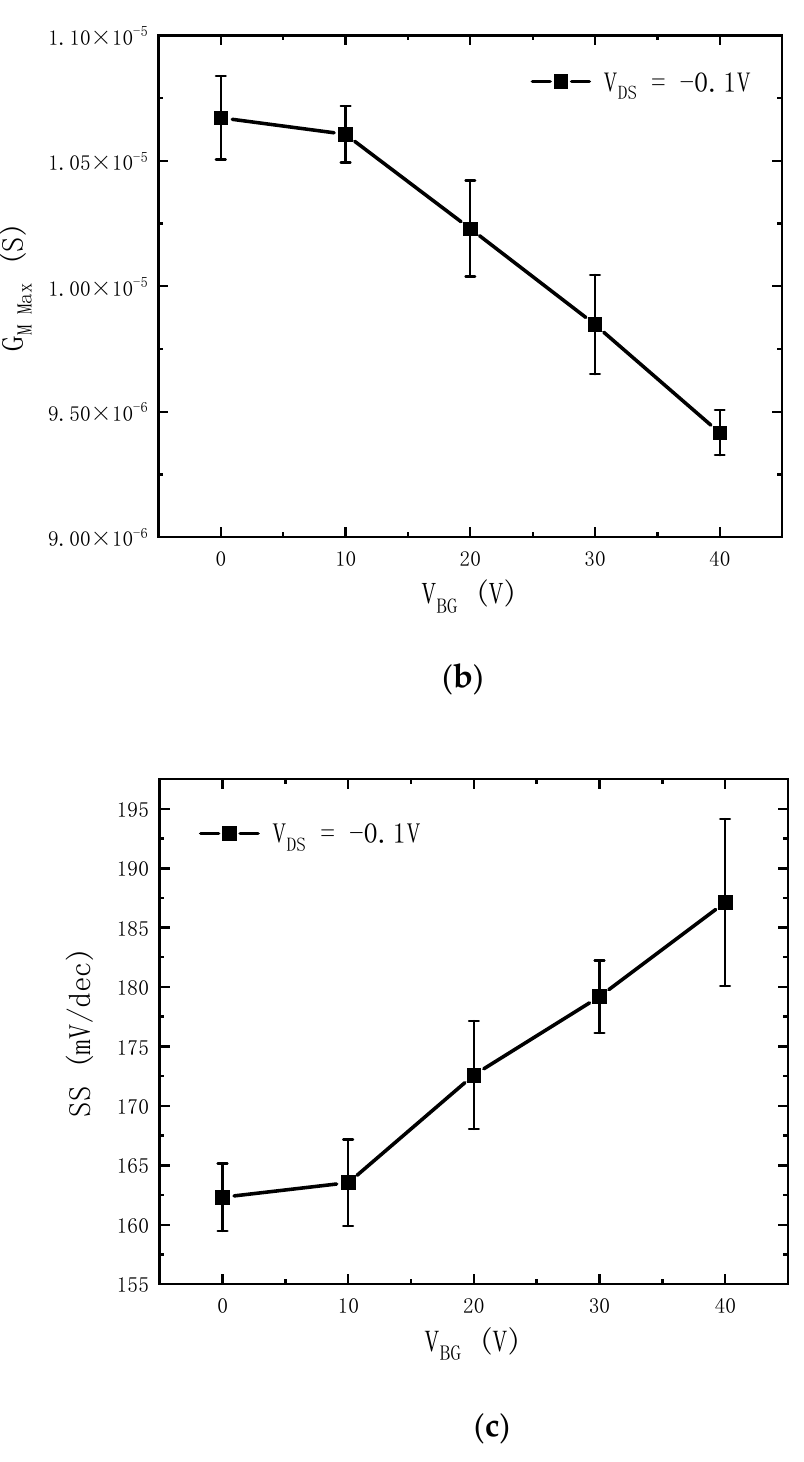
Figure 5. ( a ) The changes of threshold voltage under various substrate voltages. ( b ) Influence of different substrate voltages on transconductance. ( c ) The effect of different substrate voltages on subthreshold